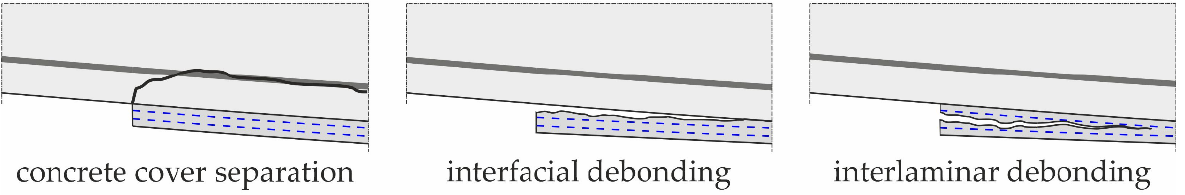
Figure 11. Failure modes in the bonding area of RC beams strengthened with carbon reinforced concrete. (Graphic: CARBOCON GMBH).